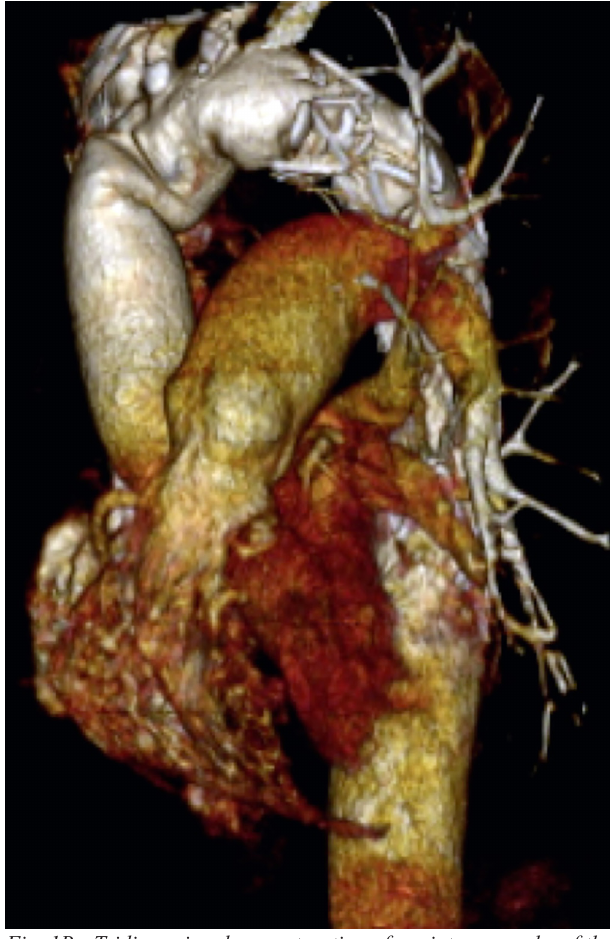
Fig. 1A - Tridimensional reconstruction of angiotomography of the aorta: preoperative.